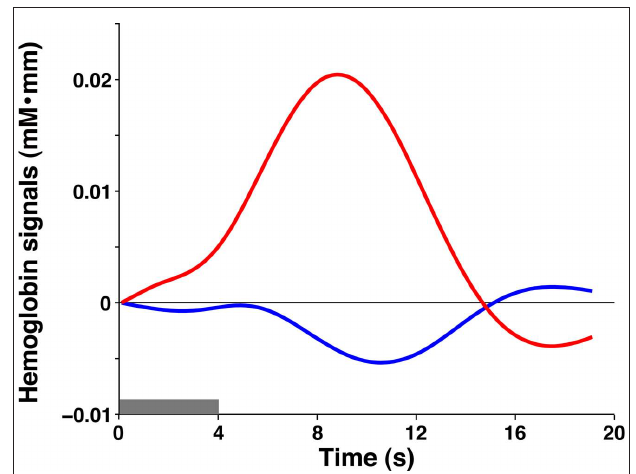
FIguRe 3 | The averaged time courses of oxy-Hb and deoxy-Hb signal changes in all the measurement channels during period 2. The gray bar indicates the period during which the speech sounds were presented (mean duration: 4.0 s). The red and blue lines indicate oxy-Hb and deoxy-Hb signals,